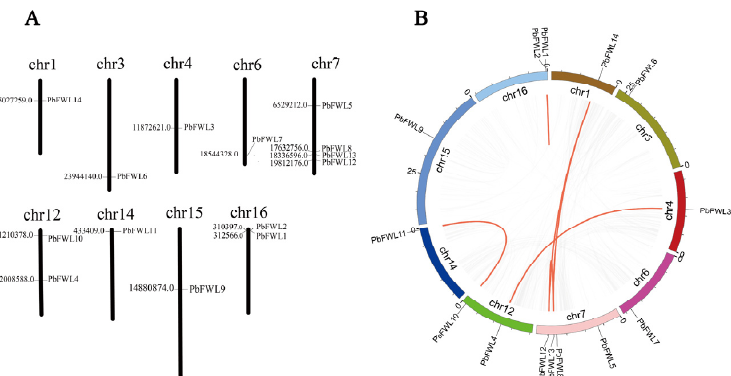
Figure 4. Schematic diagram of chromosome distribution and interchromosomal relationships of PbFWLs in pears. ( A ) The distribution pattern of PbFWLs in 9 pear chromosomes, where the chromosome number is indicated at the top of each chromosome. ( B ) The distribution pattern synteny analysis of fw2.2-like gene family of pear; the gray lines indicate all synteny blocks in the pear genome, and the red lines indicate duplicated PbFWL gene pairs.